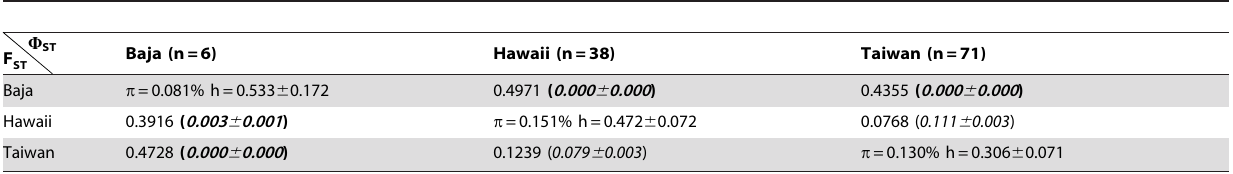
Table 3. Pairwise Fst (below diagonal) and W st (above diagonal) values for the COI gene when only Clade A haplotypes of Alopias pelagicus are analyzed.